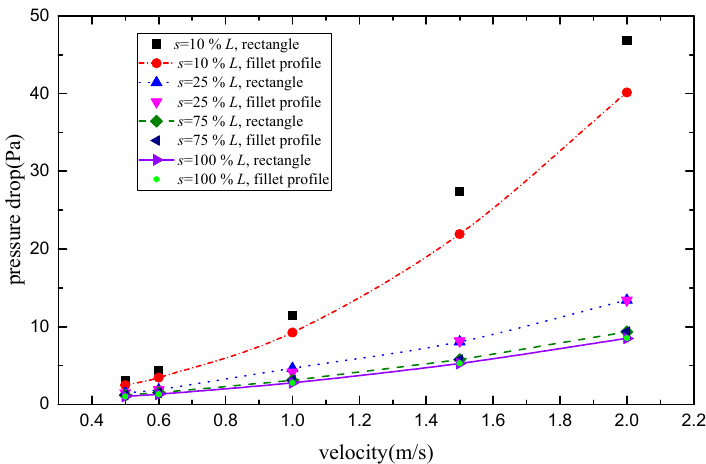
Figure 12 shows the comparison of the pressure drop for plate fin heat sinks with elliptic bottom profiles and without elliptic bottom profiles on the bottom of the channels. It can be observed that the pressure drop for the plate fin heat sink without elliptic bottom profiles is larger than that for plate fin heat sink with elliptic bottom profiles especially for the smaller inlet width. The differences of the pressure drop for the heat sink with or without elliptic bottom profiles on the bottom of the channels are not very obvious for the larger inlet width. The contact resistance is decreased with the presence of elliptic bottom profiles due to the additional substrate materials adding at the bottom of fins, which makes channels smoother. When modifying rectangular channels into channels with elliptic bottom profiles, the contact area between the cooling fluid and heat sink is slightly increased. The friction between the cooling fluid and solid and the flow resistance losses will decrease significantly as a result. The perpendicular angle bend flow in a channel with fillet profile becomes significantly smoother as well. It is worth mentioning that Figure 12 expresses the comparison of the pressure drop for the plate fin heat sink subject to impinging air flow without elliptic bottom profiles and that with elliptic bottom profiles. This modification may Figure 11. Comparisons of the pressure drop for the #4 plate fin heat sink. Figure 11. Comparisons of the pressure drop for the #4 plate fin heat sink. Figure 11. Comparisons of the pressure drop for the #4 plate fin heat sink. shed some light on a better design for heat sinks.